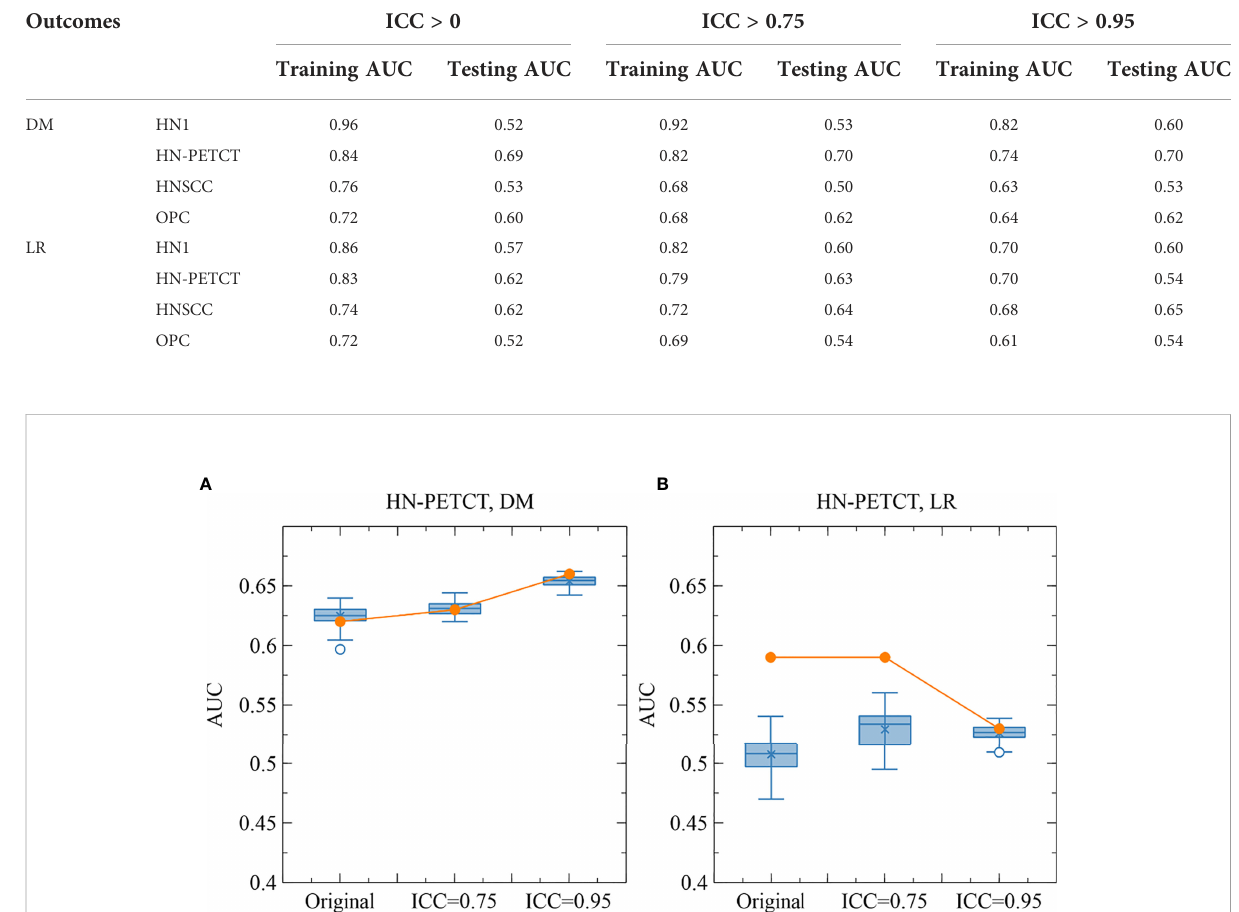
FIGURE 8 The comparison of the original and perturbed testing AUCs of HN-PETCT-298 averaged over train-test splits for the prediction of DM (A) and LR (B) using SVC. The testing AUCs showed high consistencies between the original images and perturbed images for the prediction of DM while large deviations were observed for the prediction of